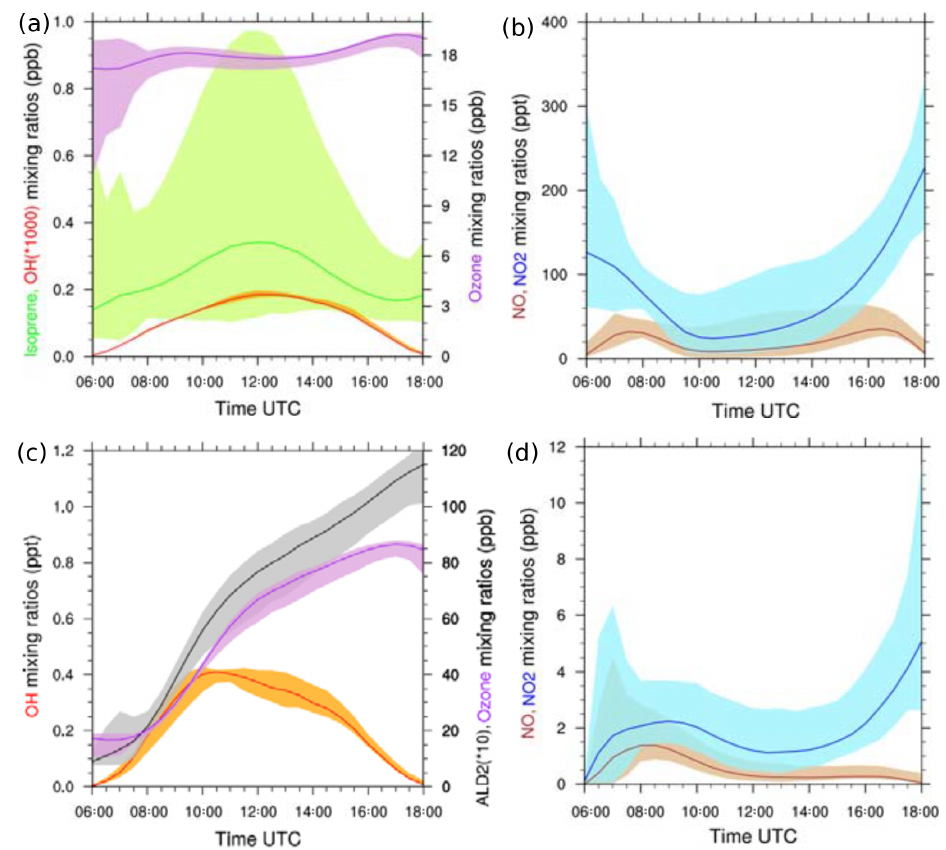
Figure 4. (a–b) LES-simulated diurnal cycles for isoprene (green), OH (red), ozone (purple), NO (brown), NO 2 (blue), (c–d) ALD2 (grey), OH (red), ozone (purple), NO (brown) and NO 2 (blue). Panels (a–b) correspond to the biogenic environment, (c–d) to the anthropogenic environment. The shaded areas denote the minimum and maximum of mean vertical profiles between the surface and 600m height, and the colored lines correspond to the averages of these